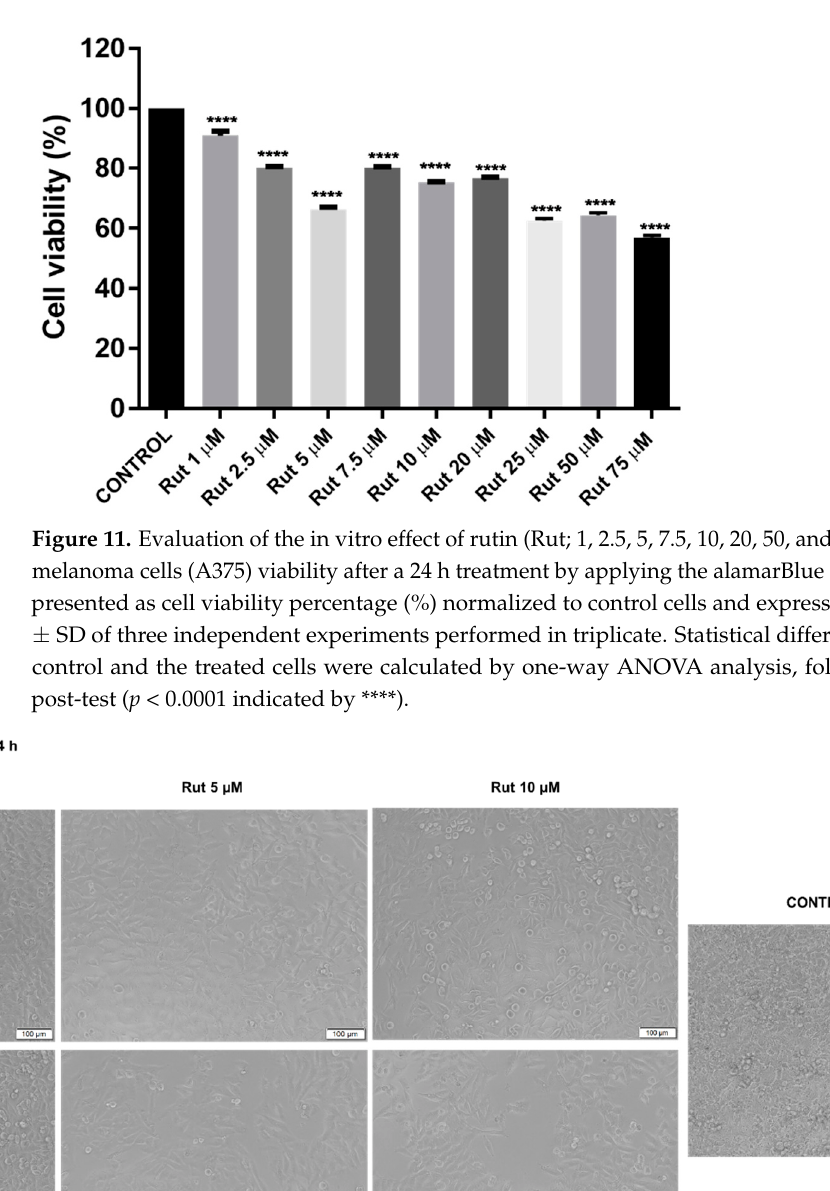
Figure 11. Evaluation of the in vitro effect of rutin (Rut; 1, 2.5, 5, 7.5, 10, 20, 50, and 75 µM) on hu- man melanoma cells (A375) viability after a 24 h treatment by applying the alamarBlue assay. The data are presented as cell viability percentage (%) normalized to control cells and expressed as mean values ± SD of three independent experiments performed in triplicate. Statistical differences